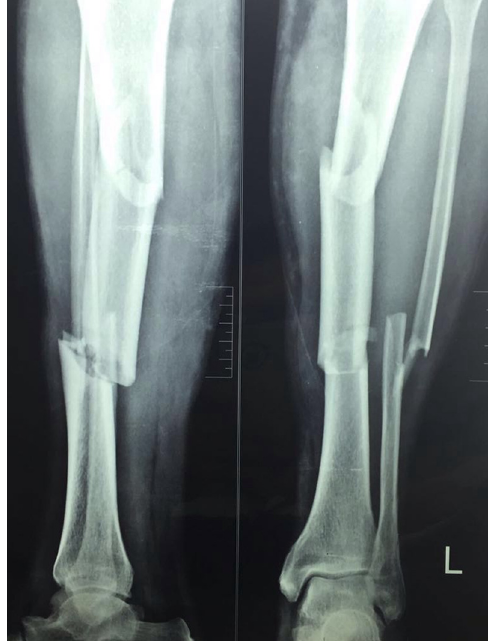
Figure 1. AP and Lat radiographs showing SFT; AO 42-C2.